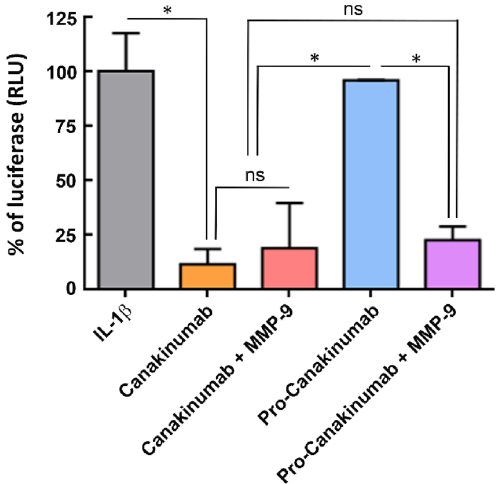
Figure 4. The neutralizing effect of pro-Canakinumab on IL-1β downstream signaling. Luciferase activity of NF-κB promoter constructs (pNF-κB-Luc) transiently transfected into HEK293 cells with or without treatment with IL-1β (10 ng/mL). IL-1β neutralizing ability was analyzed by incubating cells with saline (gray), Canakinumab (orange), pro-Canakinumab (blue), MMP-9 pre-incubated Canakinumab (pink) or MMP-9 pre- incubated pro-Canakinumab (purple) and the luciferase activity was detected through a dual-luciferase reporter assay system (Promega, Madison, WI, USA) according to the manufacturer’s protocol. IL-1β treatment was used as a control for reporter activity. The results are expressed as fold changes of luciferase activity (relative light unit, RLU) over those of internal control Renilla–Luc reporter plasmid. All data are the mean ± SD of triplicate independent experiments (n = 3). Statistical significance was calculated by t test with NS, no significance; * P <